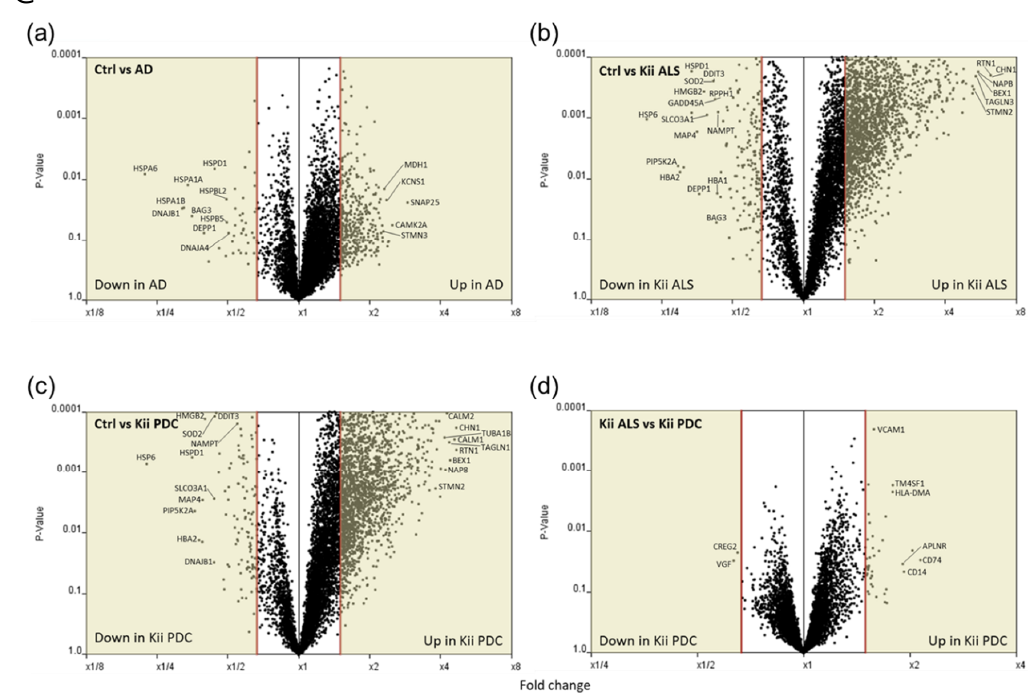
Figure 1. Microarray analysis of Kii amyotrophic lateral sclerosis and Parkinsonism-dementia complex (ALS / PDC) brains. ( A ) Clustering and ( B ) schematic principal component analysis (PCA) analysis based on control among mean control, Alzheimer’s disease, Kii ALS, and Kii PDC samples using Subio Platform. Locations of Kii ALS and Kii PDC samples are close; therefore, expression patterns between Kii ALS and Kii PDC are similar. ( C ) Volcano plots comparing control and ( a ) Alzheimer’s disease (AD), ( b ) Kii ALS, and ( c ) Kii PDC, and ( d ) between Kii ALS and Kii PDC. Cream colors indicate regions with differential gene expression greater than 1.5-fold. The number of differentially expressed genes was larger when comparing Kii ALS/PDC samples with control samples than when comparing AD samples with control samples. Antioxidants 2020 , 9 , x FOR PEER REVIEW